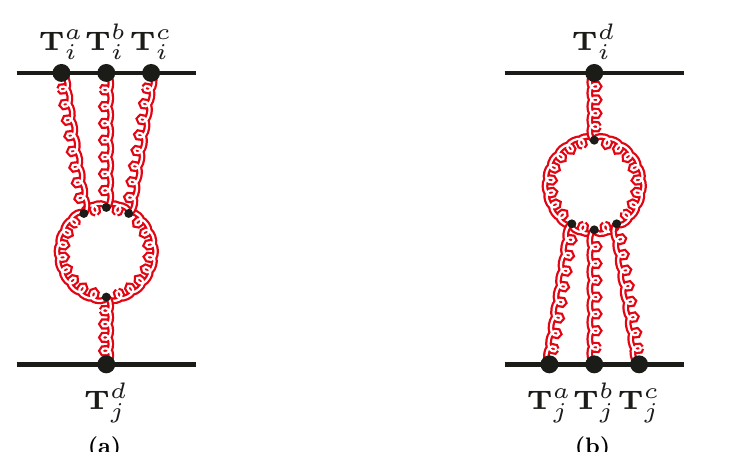
Figure 4. Diagrammatic representation of eq. (4.11). Note that the colour factor in eq. (4.12) involves a trace of four generators in the adjoint representation, symmetrically summed over six different